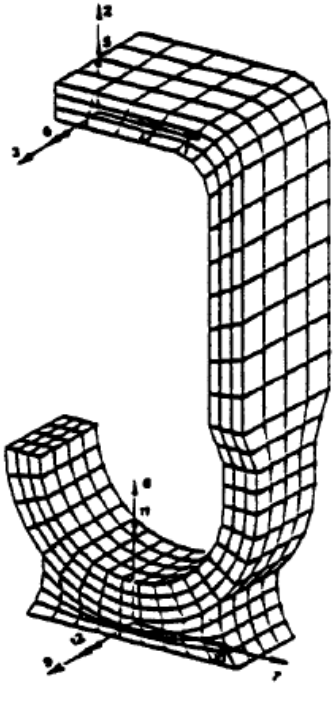
Fig. 3. Example of a detailed FE model of a J lead